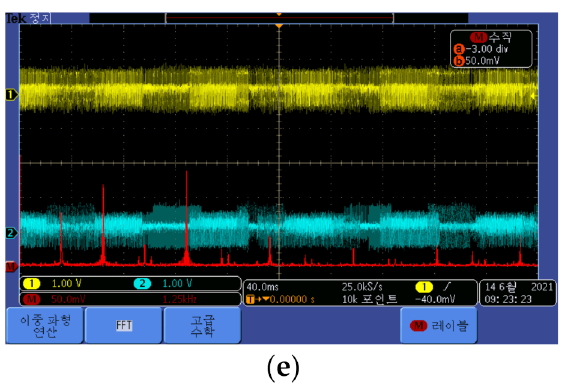
Figure 28. Disconnection detector frequency characteristics under a normal state: ( a ) 4 + 1 kHz; ( b ) 2 + 1 kHz; ( c ) 4 + 2 kHz; ( d ) 2 + 2 kHz; ( e ) overall